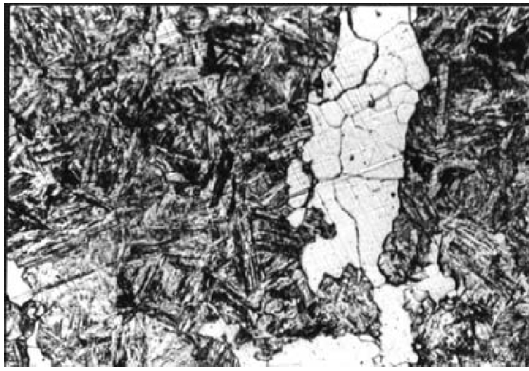
Fig. 8. Microstructure of aging samples at a temperature of 600 °C for 5 hours (200X).